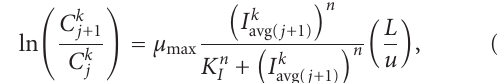
Standard error bars were created utilizing the mean value of the forecast and 95%